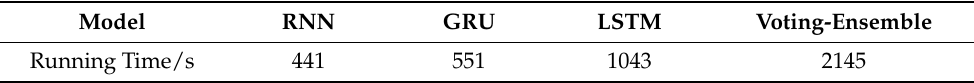
Table 7. The running time of the sub-models and the proposed voting-ensemble model.